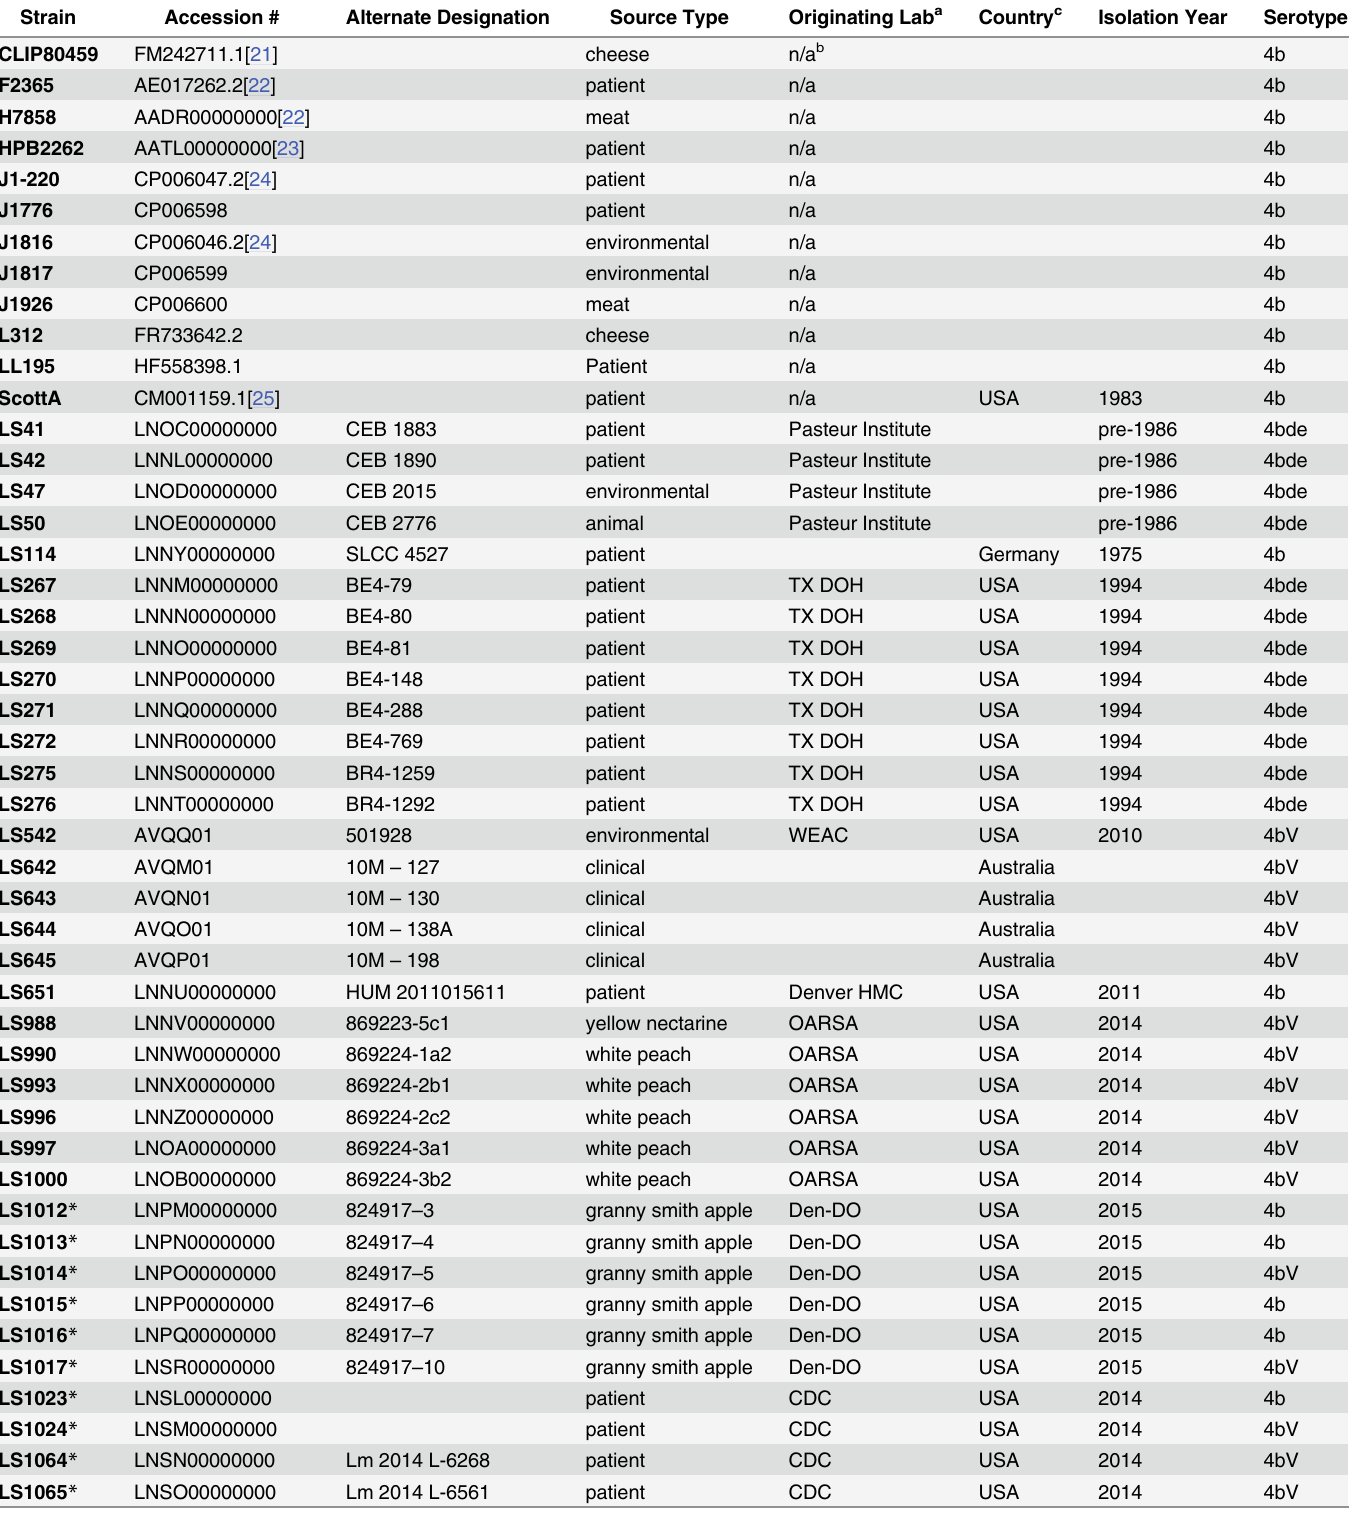
Table 1. Strains analyzed in the various phylogenetic comparisons highlighted in this paper.